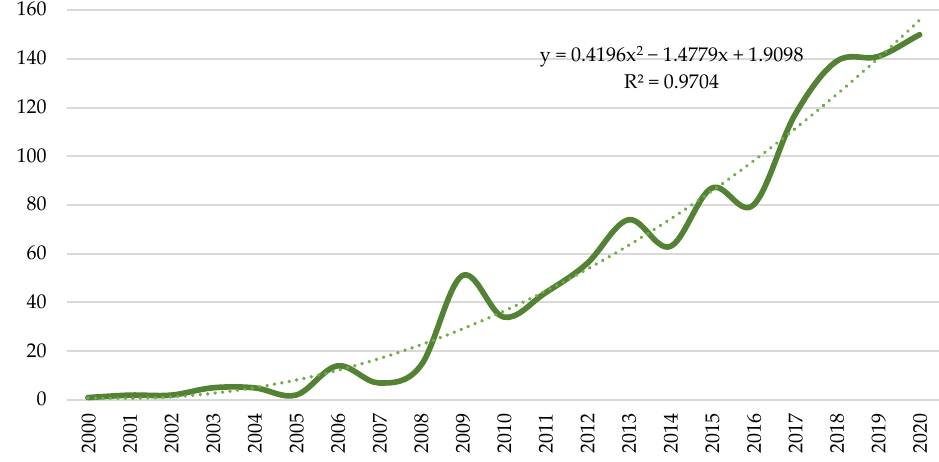
Figure 2. Number of documents published by year.